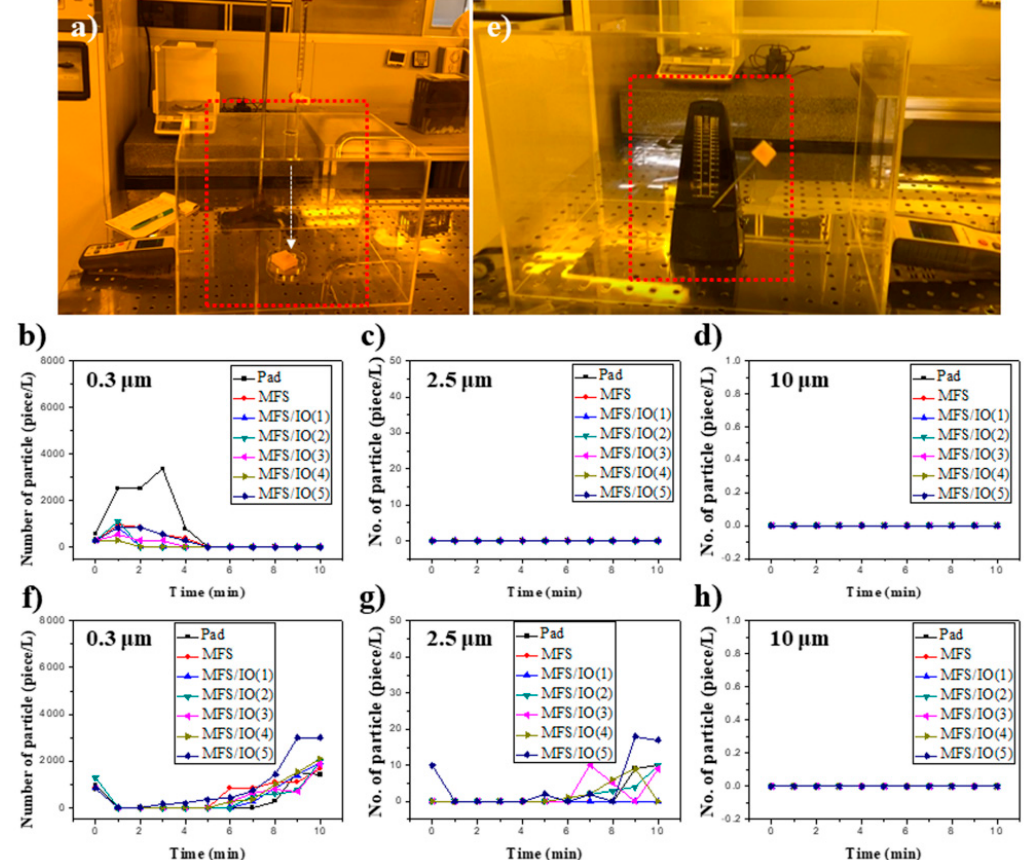
Figure 6. Dust tests of MFS / IO(3) during solution dropping under ( a ) static and ( e ) dynamic modes. Three types of absorbents, MFS, pad, and MFS / IO(1–5), were tested, and MFS / IO(3) was used as a representative image for the static and dynamic modes. Dust particles generated in the ( b – d ) static and ( f – h ) dynamic mode tests. The size of the dust particles generated from each absorbent: ( b , f ) 0.3 µ m, ( c , g ) 2.5 µ m, and ( d , h ) 10 µ m.